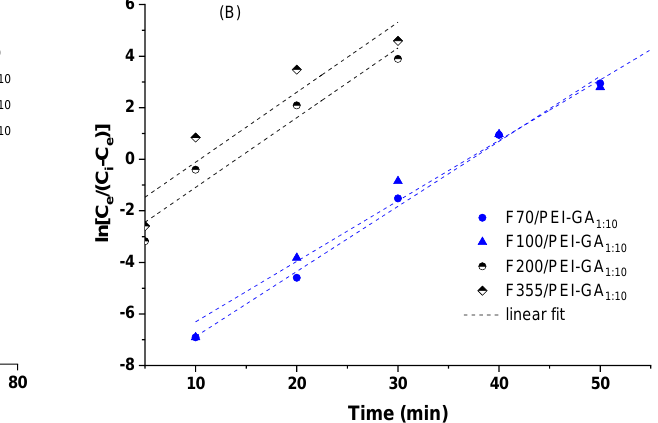
Table 3. Parameters of dynamic sorption of Cu 2+ onto sand composites determined by Thomas and Yoon – Nelson models.